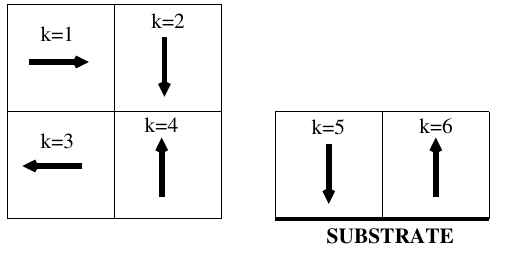
Figure 1. The allowed orientations of particles on the cubic lattice. The left part shows the top view of four “in-plane” orientations, while the right part shows the side view of two “out-of-plane” orientations. The arrows point from part B to part